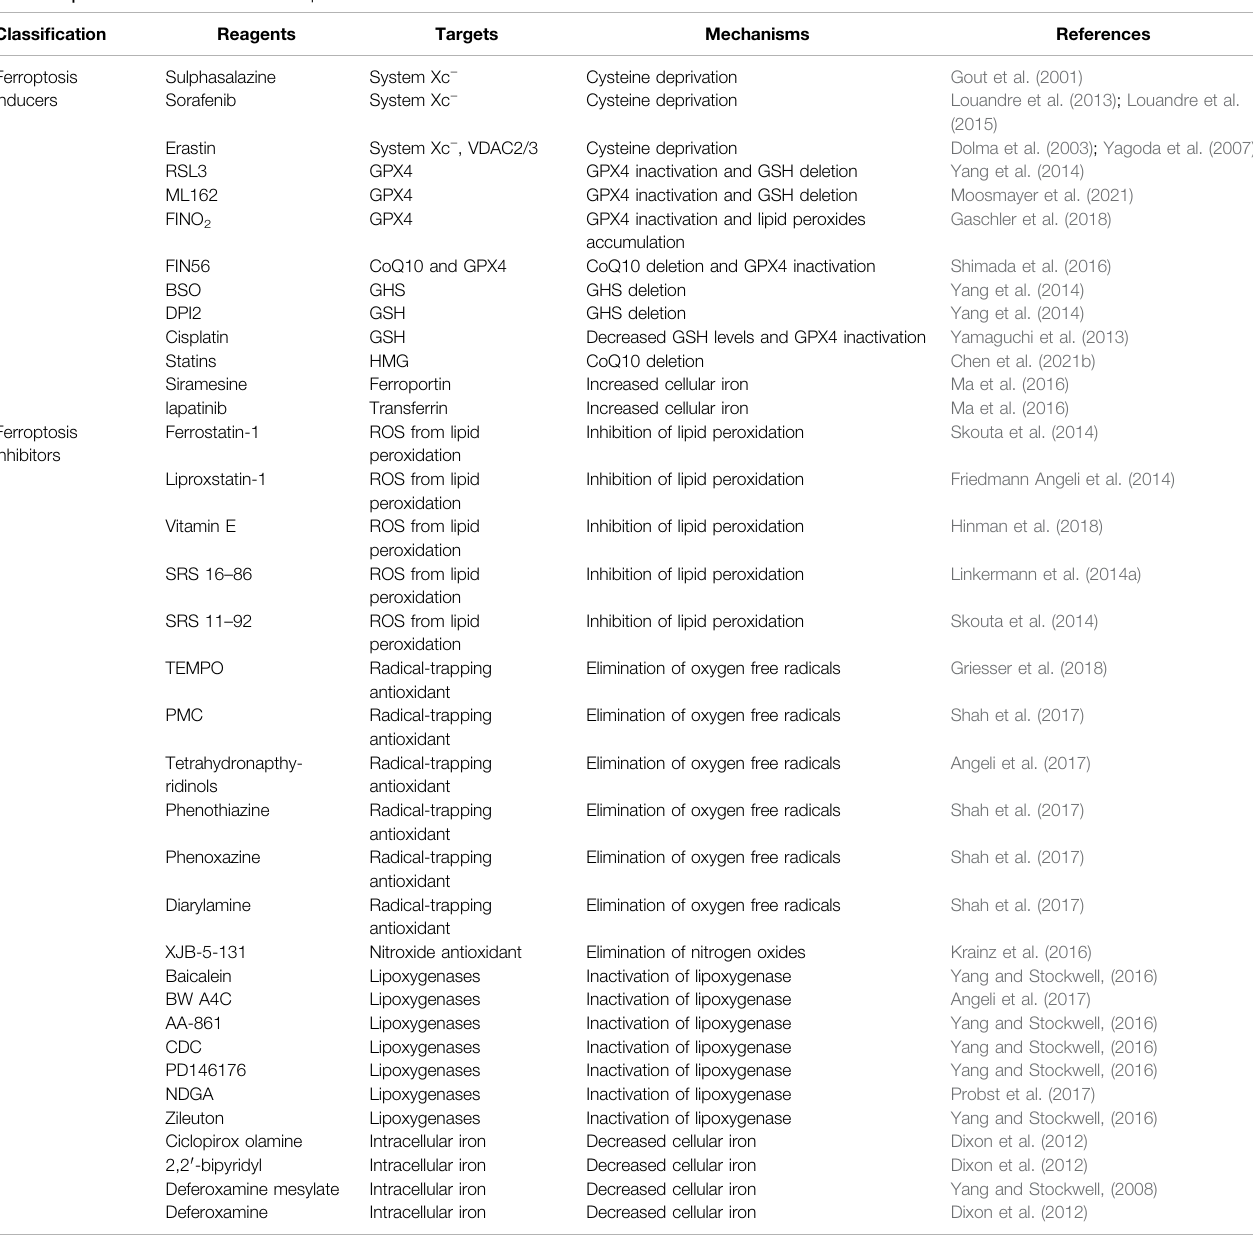
TABLE 2 | Inducers and inhibitors of